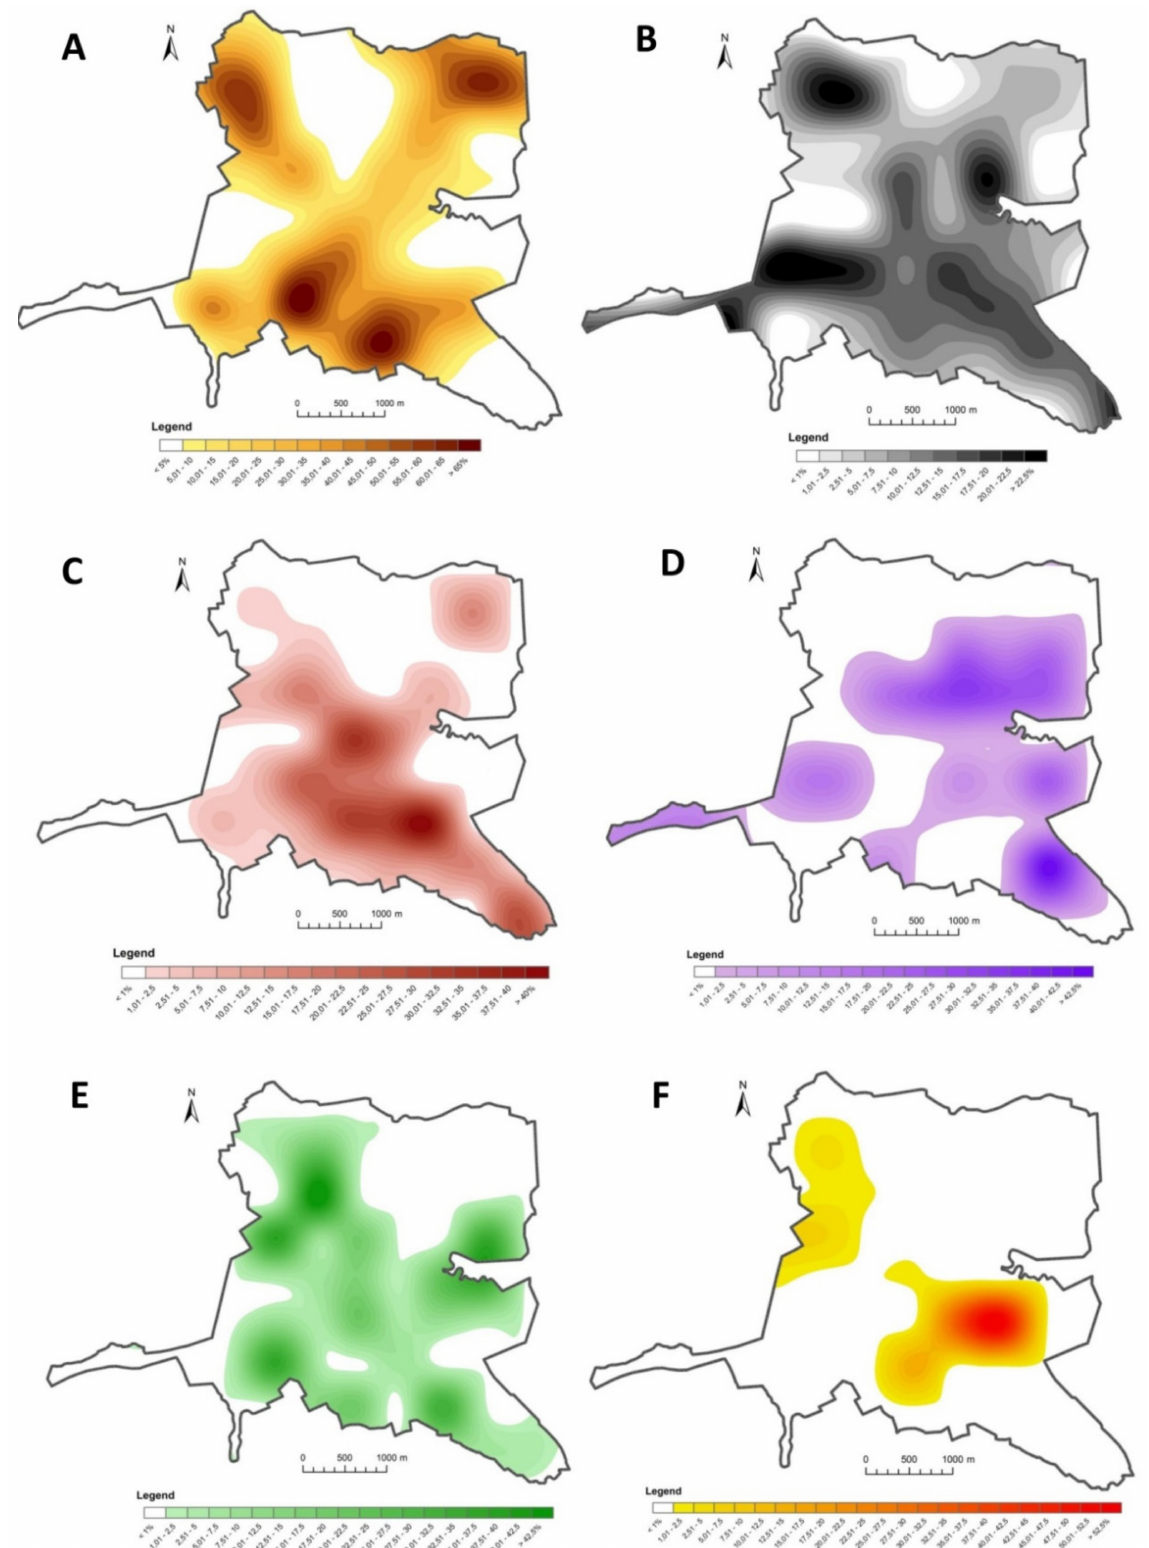
Figure 6. Intensity and concentration of residential areas ( A ), transport networks ( B ), services ( C ), industrial and storage facilities ( D ), urban green spaces and recreational areas ( E ), other developed areas ( F